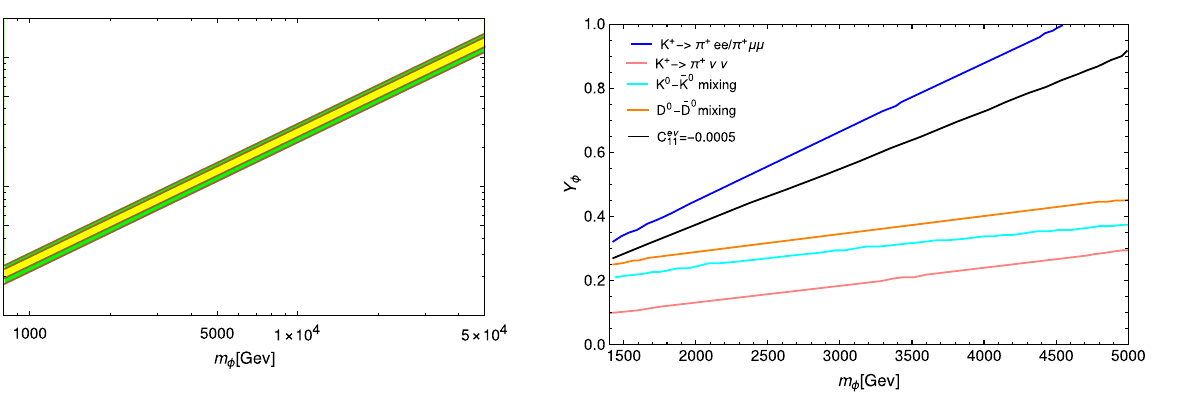
Fig. 17 Flavour constraint on Yukawa coupling of first-generation S 3 as a function of its mass [152]. The blue and red lines indicate the bounds from the ratio B ( K + → π + ee )/ B ( K + → π + μμ) and the branching fraction B ( K + → π + νν) . The cyan and orange lines indi- cate constraints from neutral kaon and D-meson mixing, respectively. The black line signifies leptoquark ( S 3 ) contribution of − 0.0005 to the ) involved in the ratio B (π → μν)/ B (π → e ν) Wilson coefficient ( C e ν 11